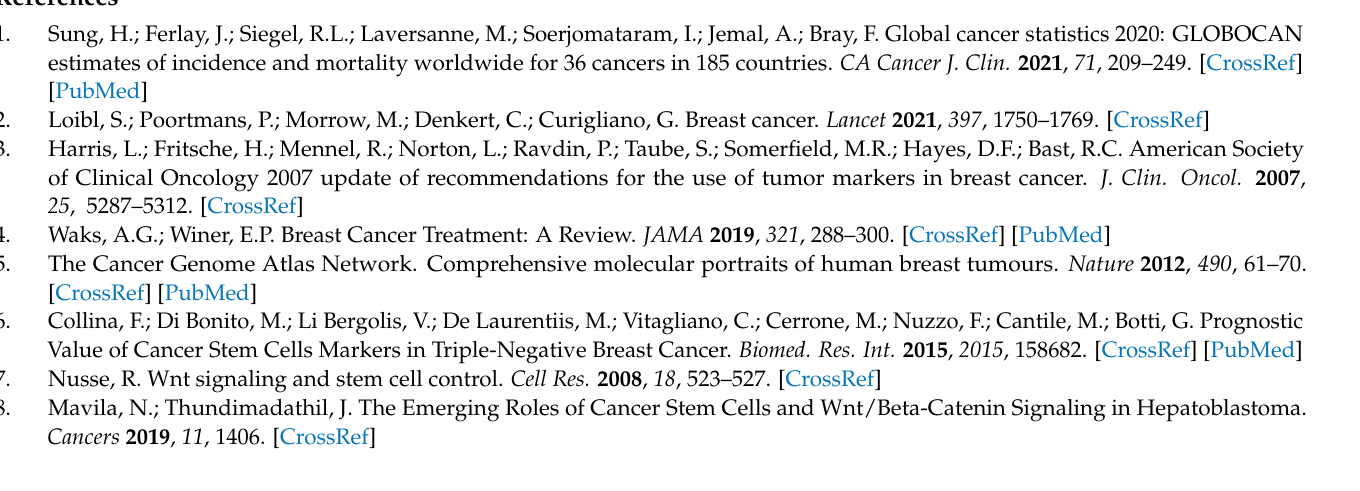
Purification scheme of a mammosphere formation inhibitor derived from Dendropanax morbiferus H.L é v. Table S1. Specific real-time RT-qPCR primer sequences containing Nanog, CD44, Oct4, c-myc, Sox2, and β -actin